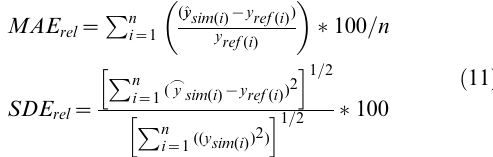
algorithm. Larger SDE in a simulation meant an algorithm performed unequally in different parts of a waveform; while small